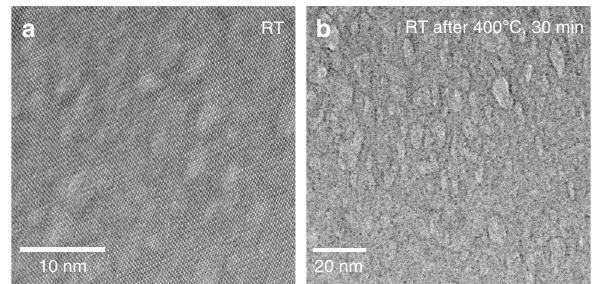
Fig. 5 Coherent nanoparticles in the brittle star spicules. a HRTEM image of a spicule, revealing brighter nanodomains, which are coherent with the matrix. b HRTEM image after in-situ heating at 400°C, demonstrating growth of the bright nanodomains and loss